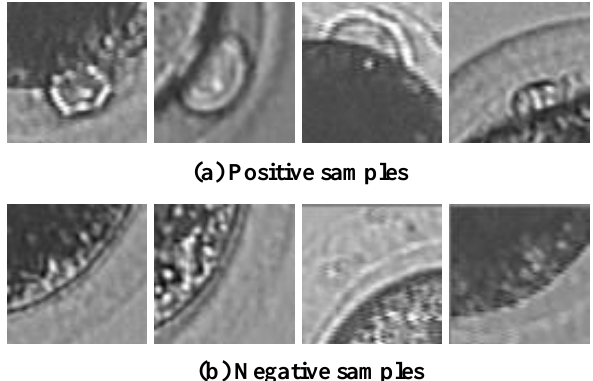
Figure 6. The sample library. ( a ) Polar body-Positive samples; ( b ) Polar body-Negative samples.